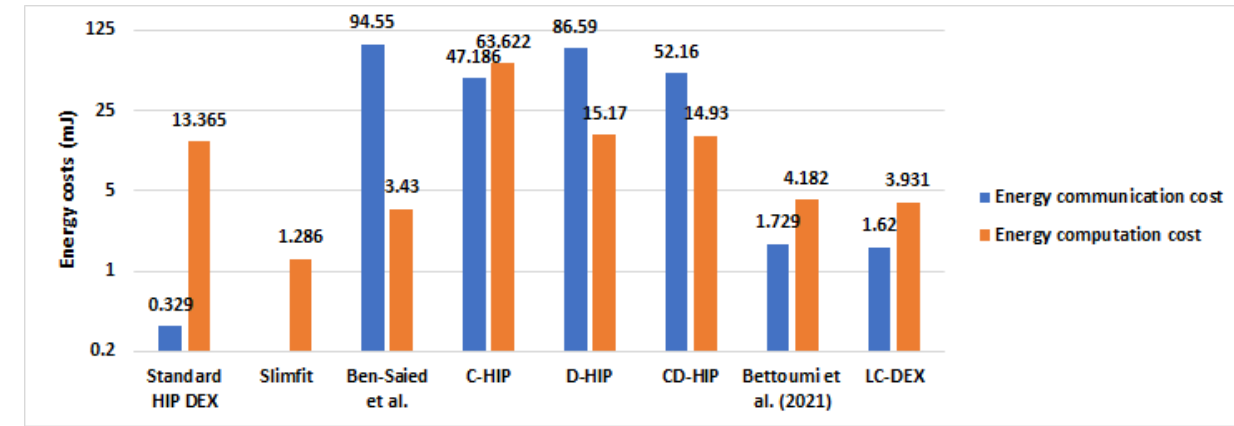
Figure 15. Computational and communication energetic costs of evaluated solutions in comparison with LC-DEX.